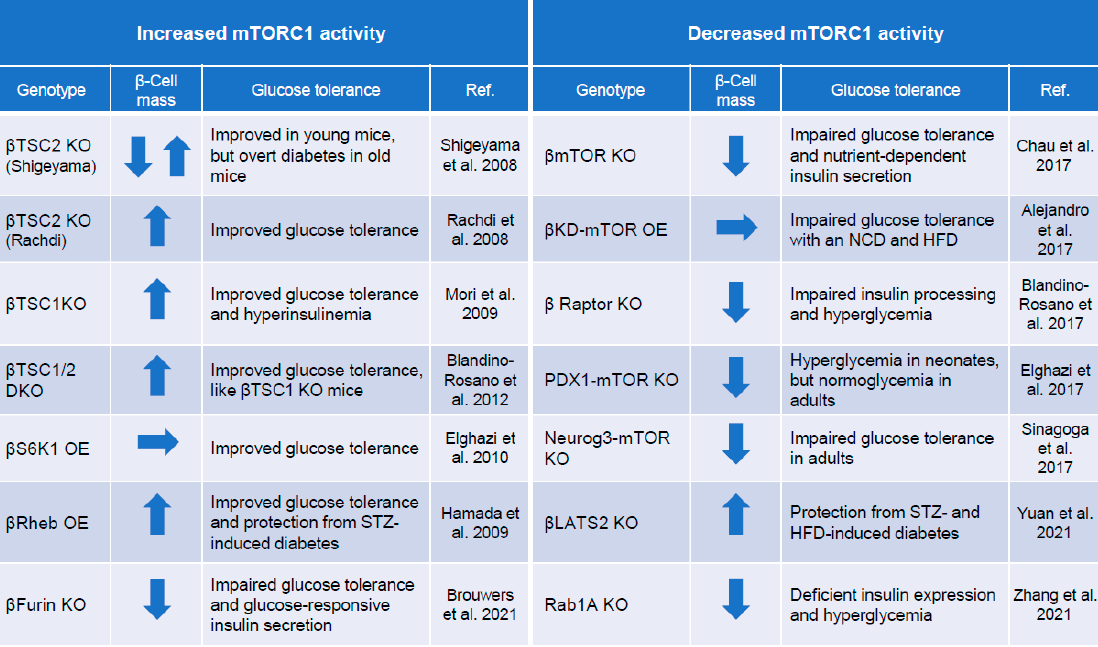
Figure 3. Pancreatic β -cell mass and glucose tolerance in mTORC1-related transgenic mice. In genetically modified mice related to mTORC1 activity in pancreatic β -cells, changes in mTORC1 activity affect pancreatic β -cell mass and glucose tolerance. In this figure, the left panels show mice with increased mTORC1 activity [24,44,73,74,76,79,84], and the right panels show mice with decreased mTORC1 activity [77,78,80,83,85–87]. In β -cell mass regulation, up arrows indicate an increase, down arrows indicate a decrease, and horizontal arrows indicate no change. The coexistence of upward and downward arrows indicates change in response to age. DKO: double knockout, HFD: high-fat diet, KD: kinase dead, KO: knockout, NCD: normal chow diet, OE: overexpression, STZ: